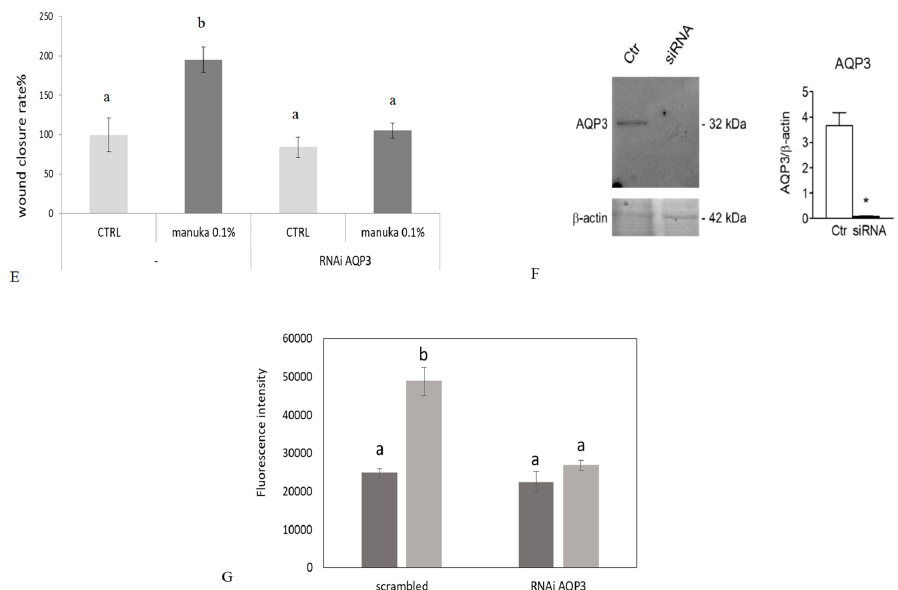
Figure 5. The genetic silencing of AQP3 abolishes the Ca 2+ response to manuka honey and prevents wound closure in vitro. ( A ) Expression of AQPs genes in HaCaT cells exposed to different honey sample. The mRNA quantity of AQPs was determined by qRT-PCR and is represented as mean relative expression ± SD ( n = 3). Different letters above bars indicate statistical difference determined by One-way ANOVA followed by Bonferroni post-test ( p < 0.01). ( B ) Aquaporin-3 (AQP3) protein expression in HaCaT cells after manuka honey exposure. C is control condition, M is manuka honey treatment. Blots representative of three were shown. Lanes were loaded with 30 µg of proteins, probed with anti-AQP3 rabbit polyclonal antibodies and processed as described in Materials and Methods. The same blots were stripped and re-probed with anti- β -2-microglobulin (B2M) polyclonal antibody, as housekeeping. A major band of about 32 kDa was observed (* p < 0.001, t -test). ( C ) The Ca 2+ response to 4% v / v manuka honey was suppressed in HaCaT cells transfected with a RNAi selectively targeting AQP3. The arrow indicates the addition of manuka honey after 60 s. Data are presented as means ± SEM of [Ca 2+ ] i traces recorded in different cells. Number of cells: manuka honey: 40 cells from 3 exp; manuka honey after RNAi for AQP3: 40 cells from 3 exp. ( D ) Mean ± SEM of the Ca 2+ response to 4% v / v manuka honey recorded at the peak (light bars) and at the plateau (dark bars) under the designate treatments. Number of cells as in C . Different letters above bars indicate statistical difference determined by One-way ANOVA followed by Bonferroni post-test ( p < 0.01). ( E ) Effect of AQP3 RNAi on honey-induced scratch wound repair of HaCaT monolayers. Wound closure rate is expressed as the difference between wound width at 0 and 24 h. Data were recorded 24 h after scratch wound healing of cells exposed to 0.1% manuka honey. Bars represent mean ± SEM of wound closure inhibition deriving from two independent experiments, each with n = 20. Different letters on bars indicate significant differences according to Tukey’s test ( p < 0.01). ( F ) Aquaporin-3 (AQP3) protein expression in HaCaT cells after AQP3 RNAi. Blots representative of three were shown. Lanes were loaded with 15 µg of proteins, probed with anti-AQP3 rabbit polyclonal antibodies and processed as described in Materials and Methods. The same blots were stripped and re-probed with anti- β -actin polyclonal antibody, as housekeeping (* p < 0.001, t -test). ( G ) Fluorescence values recorded at 10 min. in scrambled or silenced (RNAi AQP3) cells, in control conditions (dark bars) or incubated with 4% manuka honey (light bars). Data are presented as means ± SD of rhodamine 123 fluorescence expressed in arbitrary units; n = 16 microplate wells from two different experiments. Different letters on bars indicate significant differences according to Tukey’s test ( p < 0.01). To assess the role played by AQP3 in manuka honey-induced wound repair, we performed the scratch wound assay after silencing of AQP3 by RNAi (as shown in Figure 5F). In silenced